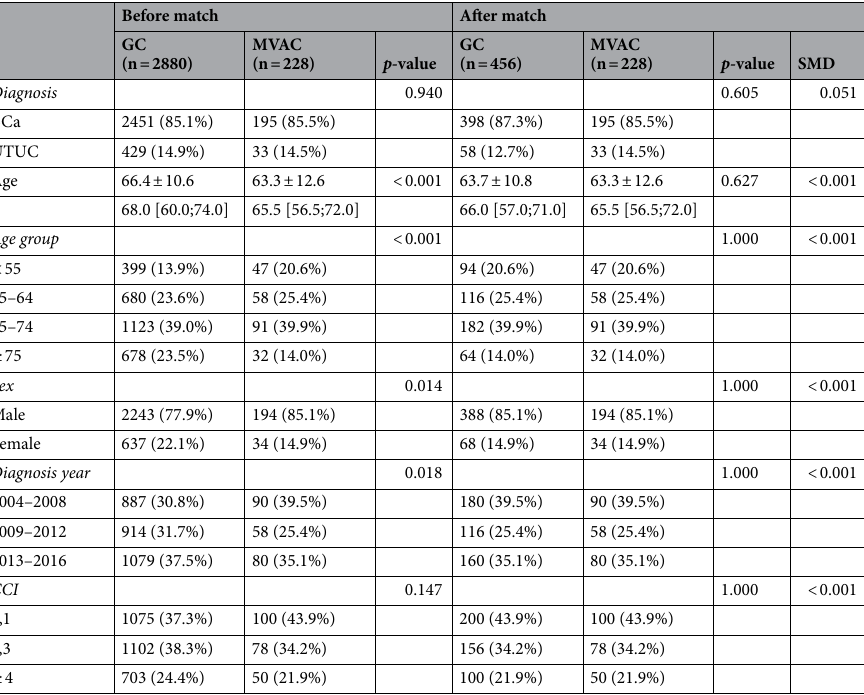
Table 1. Baseline Characteristics of the Study Population. Data are presented as n (%), mean ± standard deviation, or median [interquartile range]. GC, Gemcitabine + Cisplatin Chemotherapy; MVAC,